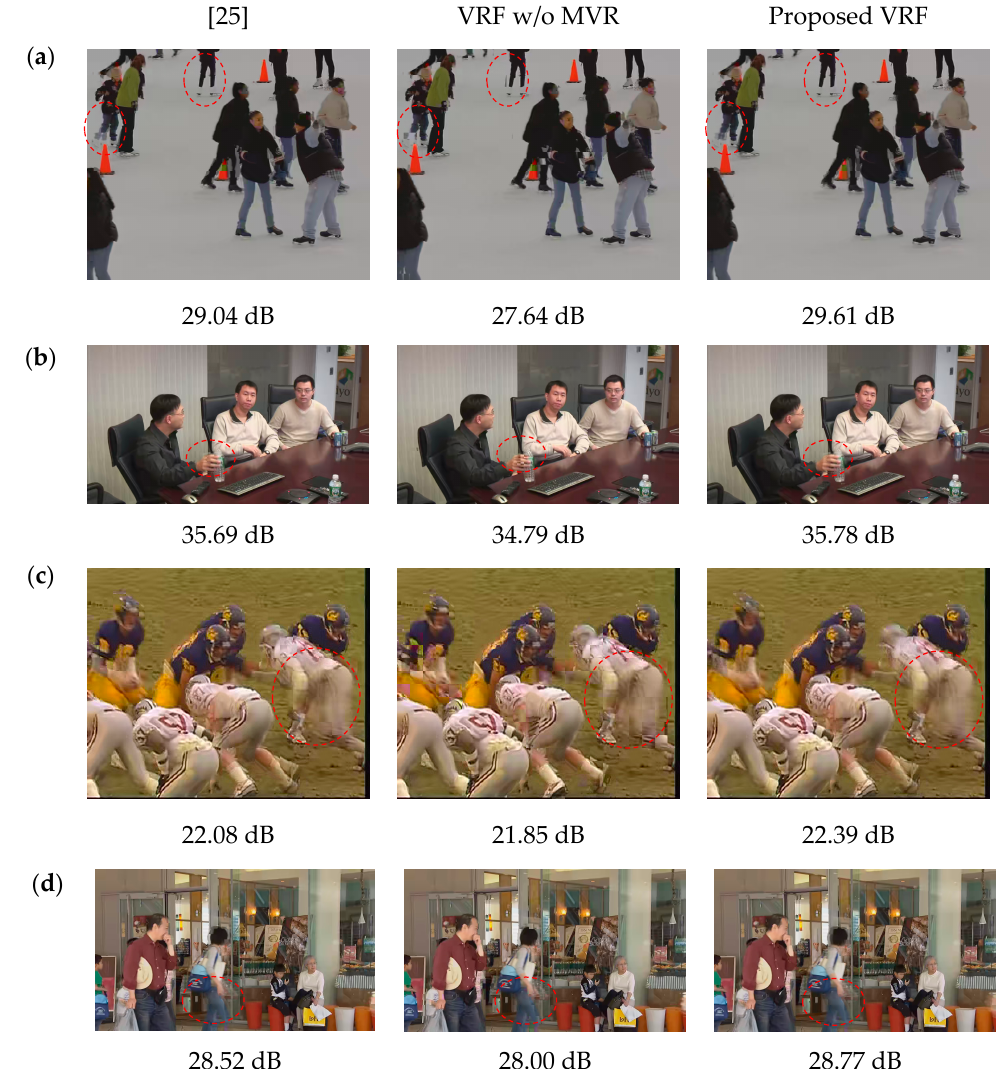
Figure 11. VRF visual quality illustration ( highlighting the improvement in the red-circle ): ( a ) Ice; ( b ) Vidyo1; ( c ) Football; ( d ) BQMall.